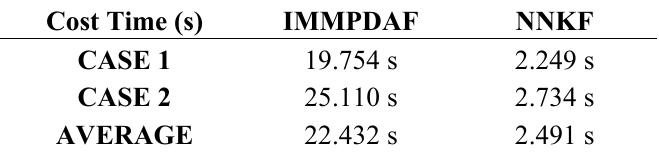
Table 3. Computation performance of IMMPDAF and NNKF for Cases 1 to 2. Lower values are